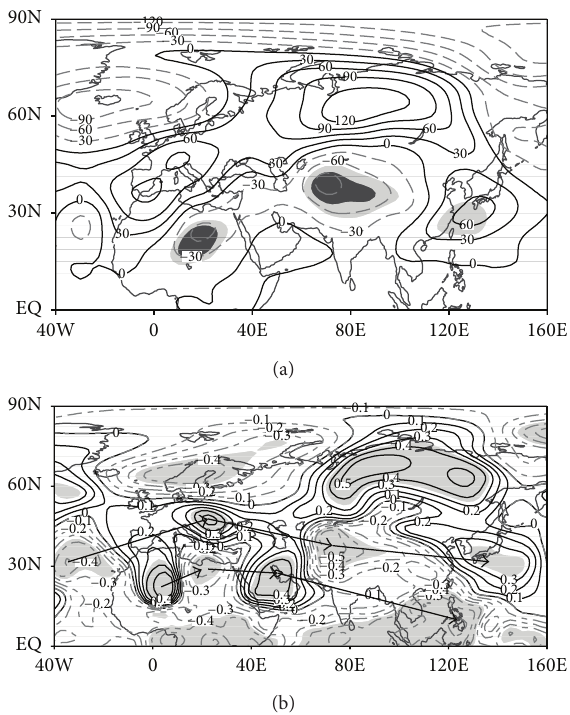
Figure 3: Composite 500 hPa geopotential height field departure and 𝑡 -test for January 11–30, 2008 (a), and correlation coefficient analysis of plateau surface heating anomaly and 500 hPa geopo- tential height anomaly (b) (the shaded gray area is significant at 95% confidence level ( 𝑡 -test); the solid/dotted line indicates positive/negative anomaly or